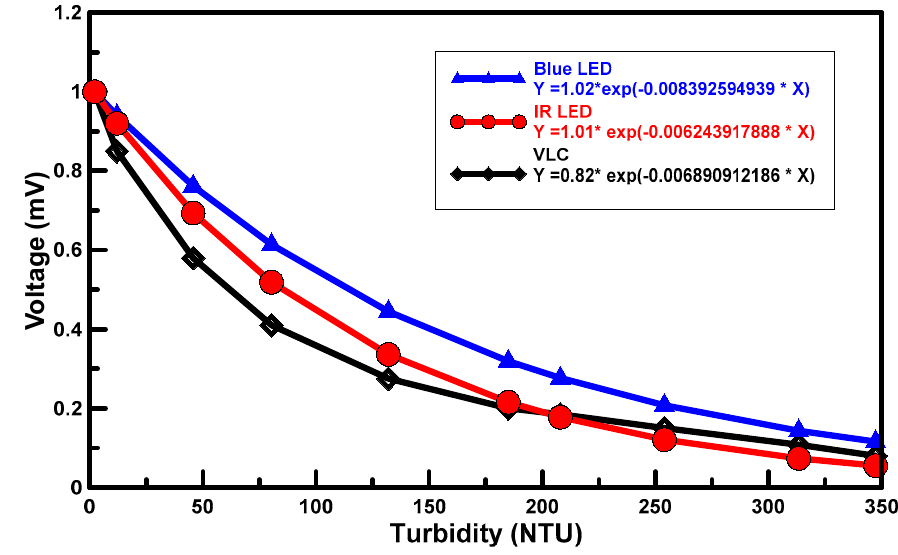
Figure 4. Turbidity effect in nephelometric units (NTU).